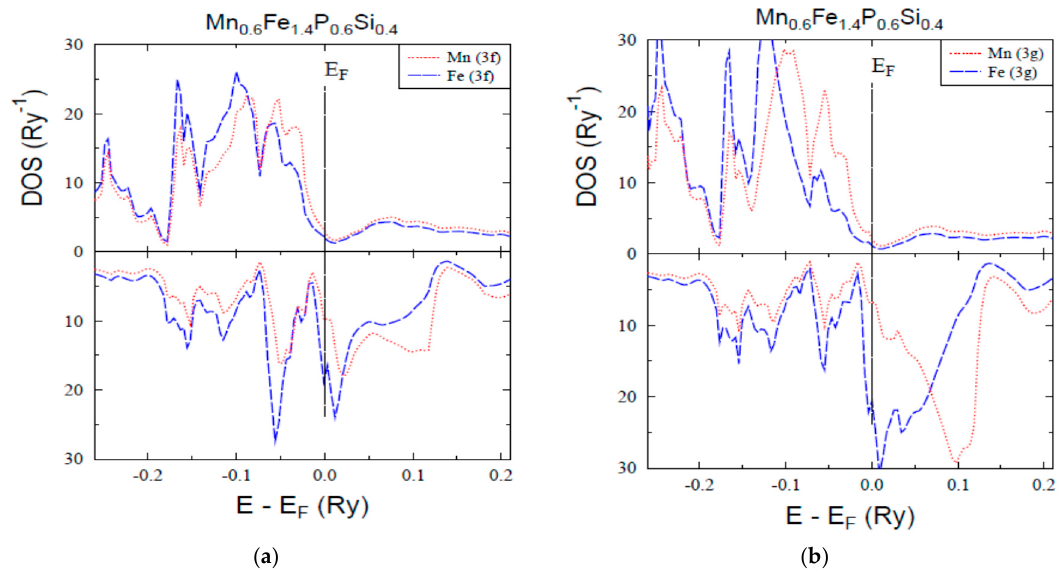
Figure 13. Density of states calculated for Mn and Fe in Mn 0.6 Fe 1.4 P 0.6 Si 0.4 ( a ) for Mn and Fe on 3f sites and ( b ) for Mn and Fe on 3g sites.